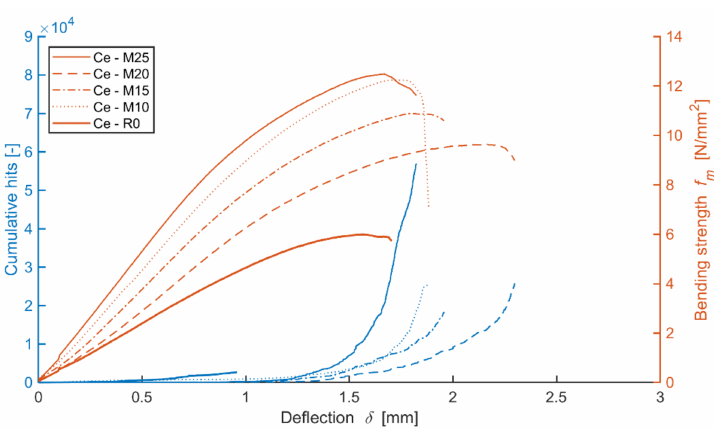
Figure 16. Comparison of bending strength, deflection and cumulative hits of representative test spec- imens (during mechanical load) of mixture Ce (reference boards) before and after frost/defrost